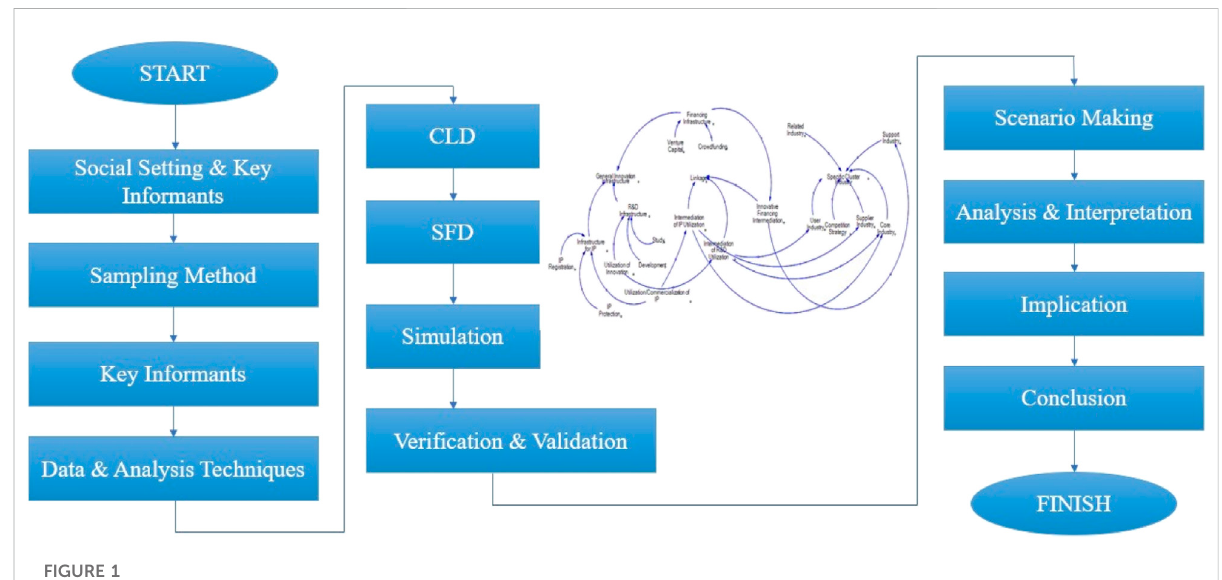
FIGURE 1 Research Flow. Source: Adapted from Fatmawati